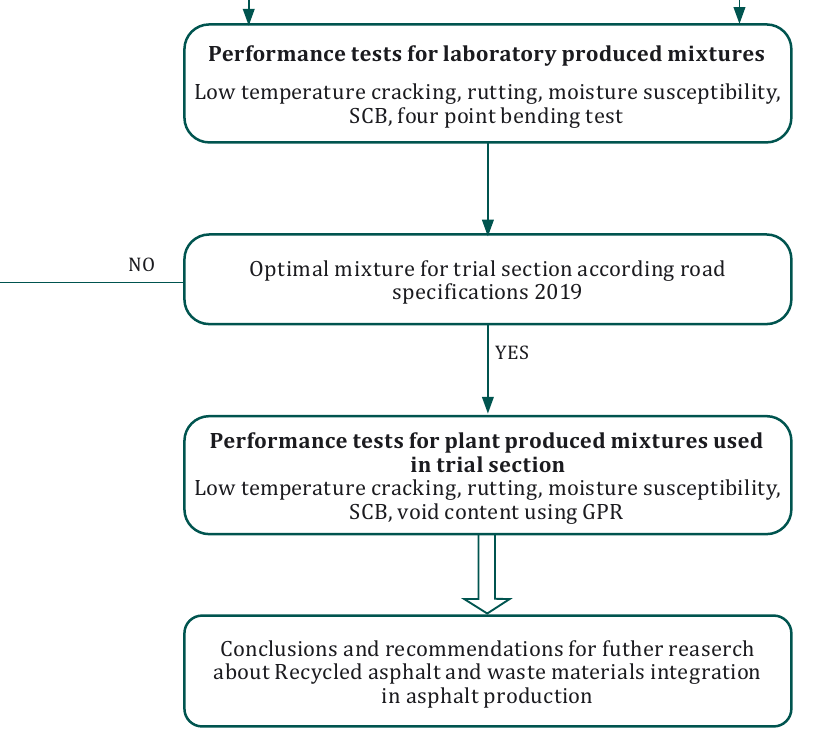
Performance tests for laboratory produced mixtures